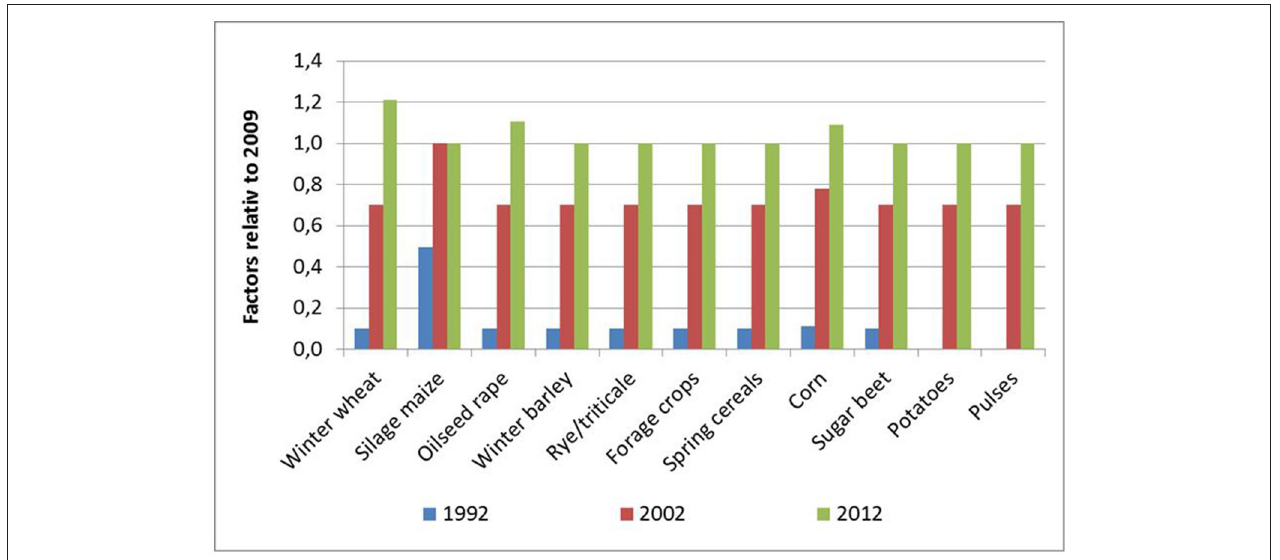
FIGURE 1 | Expert estimations of the relative deviances from the reference year 2009 (Steinmann et al., 2012) on the amount of GLY applied in pre-sowing applications of GBH to arable crops in the three investigation years.